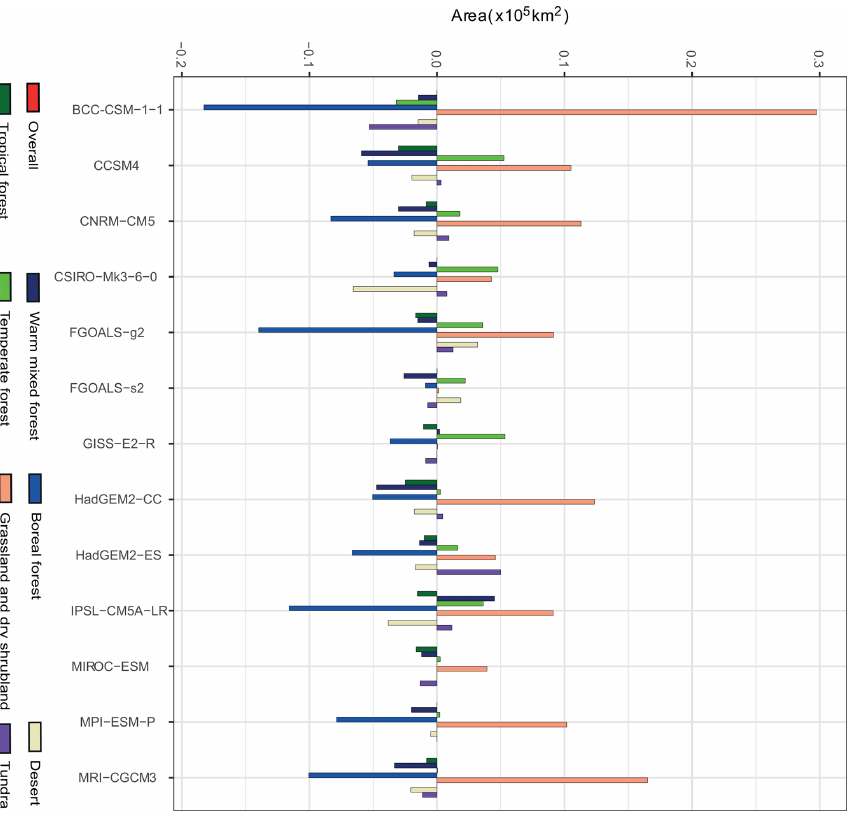
Figure 6. Changes in the extent of each megabiome as a consequence of simulated climate changes for each model, both expressed as change relative to the PI extent of the same